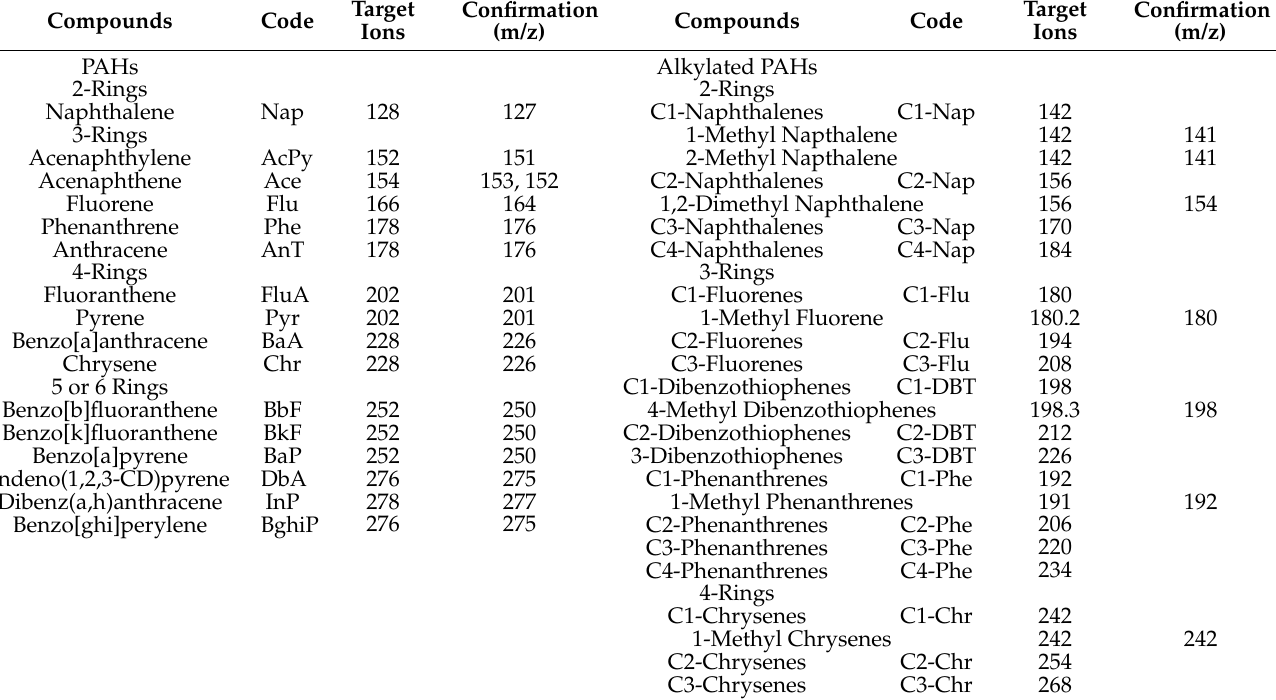
Table 2. Quantitative ion values used in the analysis of 16 PAHs and alkyl PAHs.